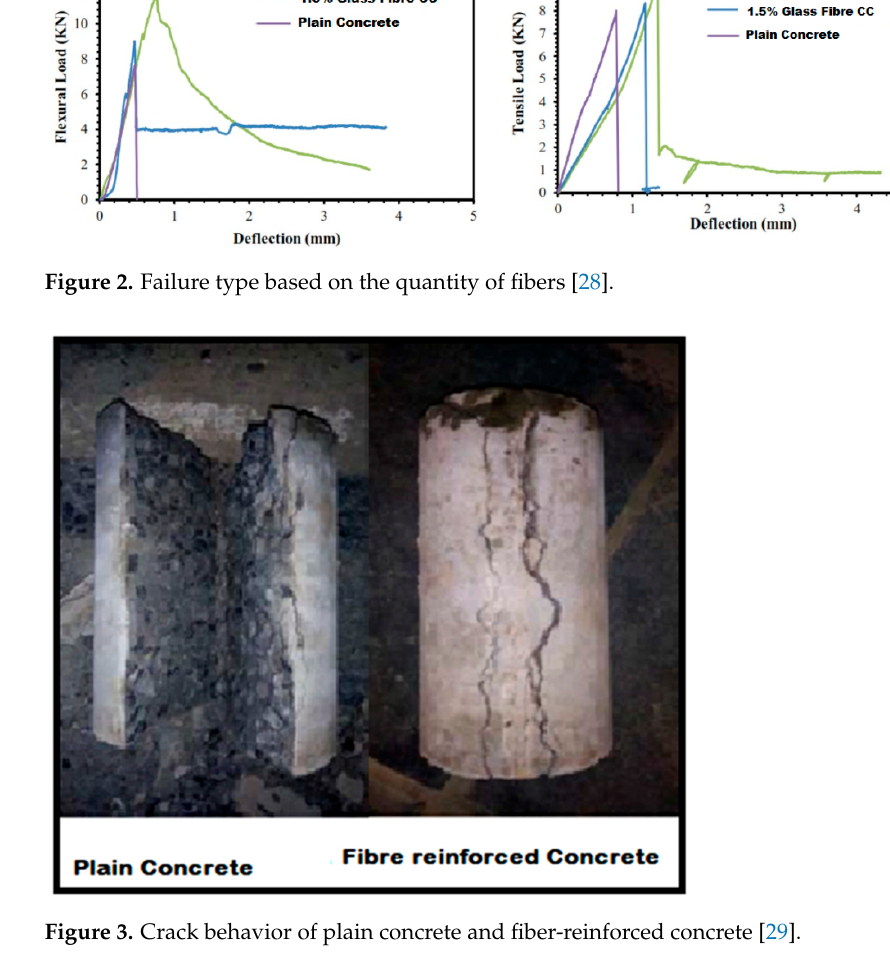
Figure 3. Crack behavior of plain concrete and fiber-reinforced concrete [29].